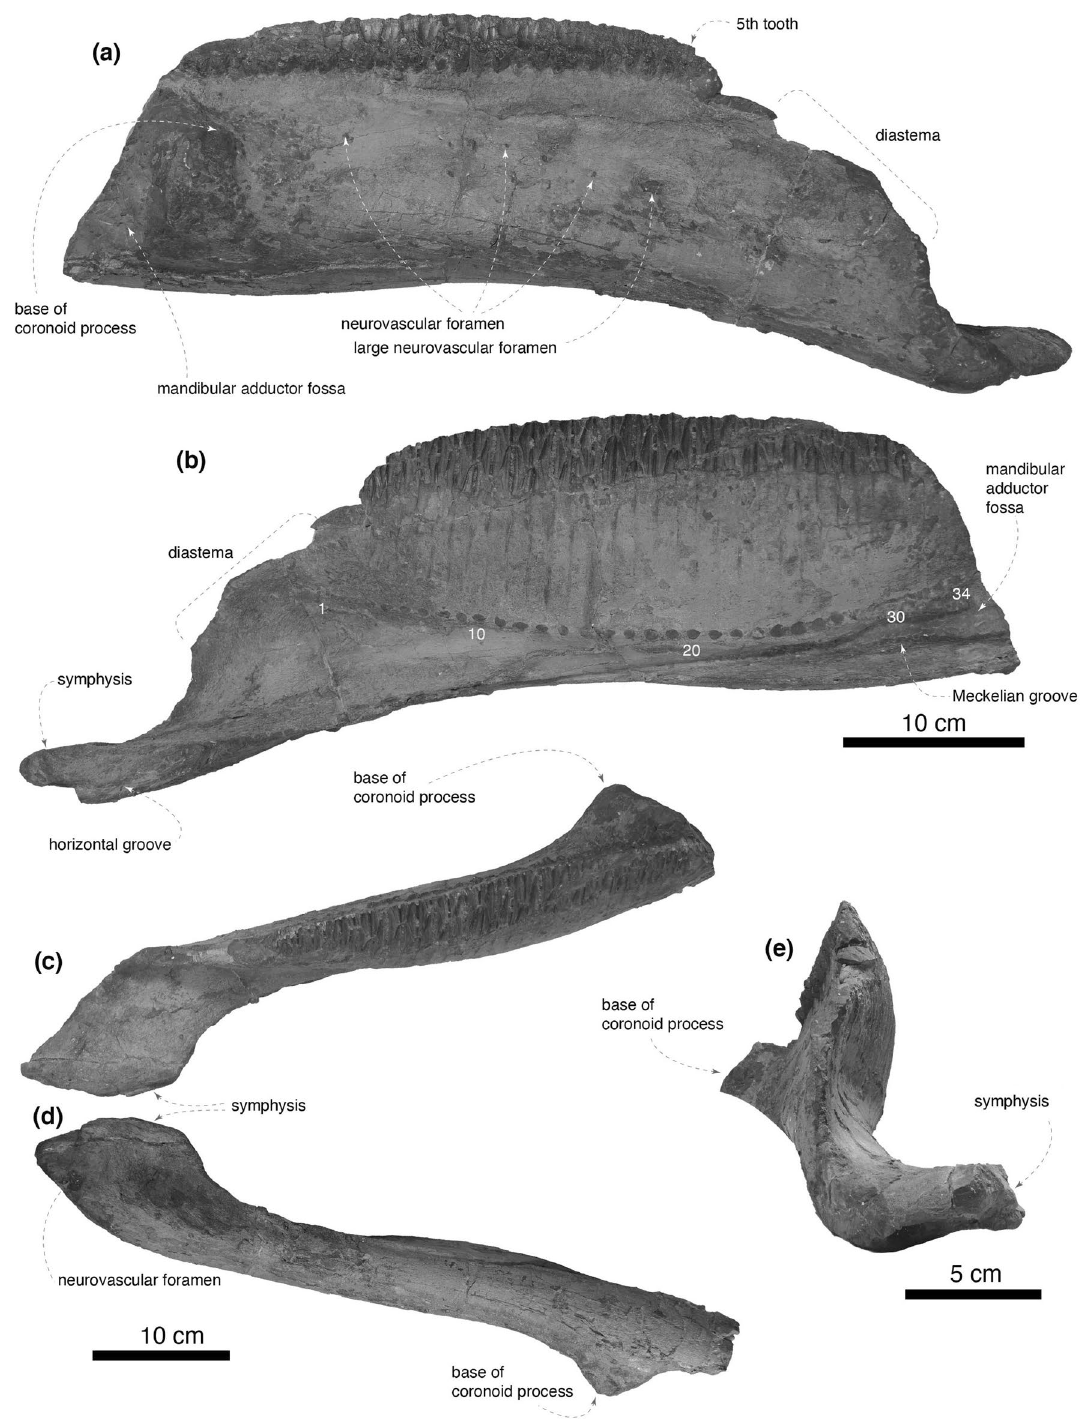
Figure 2. Right dentary of Yamatosaurus izanagii gen. et sp. nov. in lateral ( a ), medial ( b ), dorsal ( c ), ventral ( d ), and anterior ( e ) views. Numbers in white in ( b ) indicate the positions of nutrient